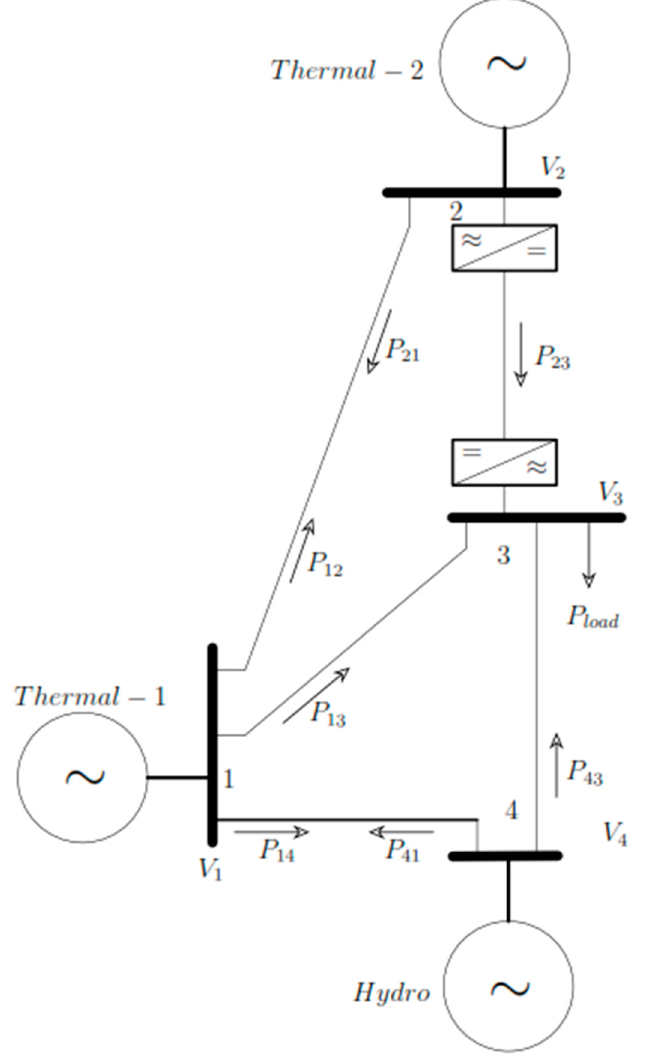
Figure 4. Four (4) bus AC system with HVDC link.